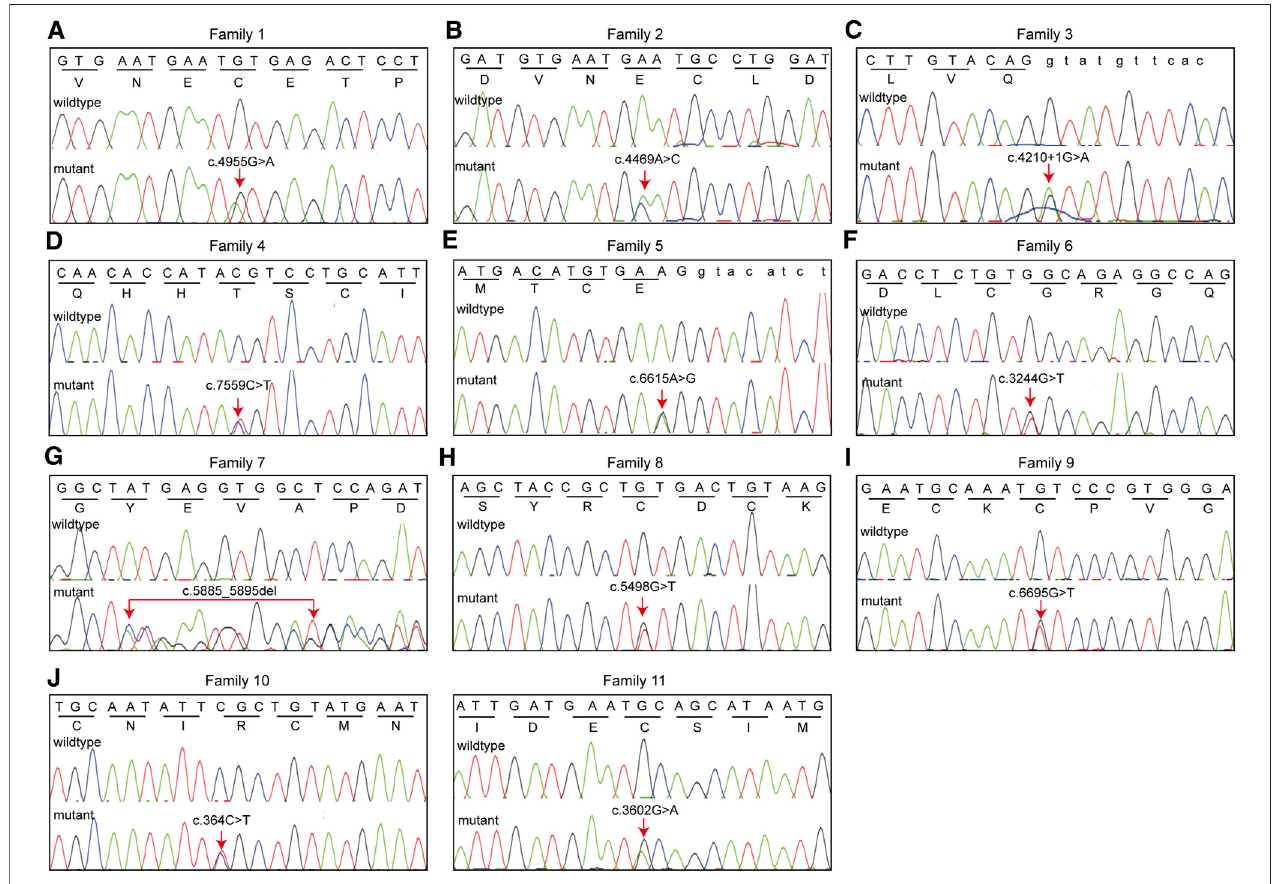
FIGURE 3 | Eleven FBN1 mutations identi fi ed in 11 families with MFS were validated using Sanger sequencing. We presented nucleotide sequence and corresponding amino acid sequence.